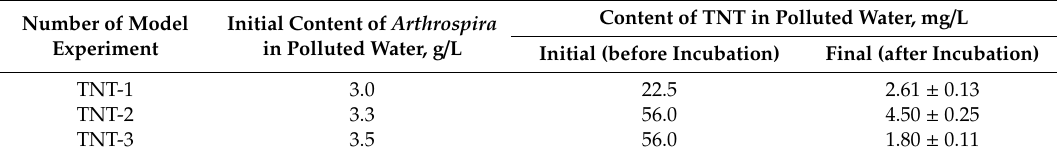
Table 2. Results of model experiments for cleaning water polluted with TNT by using Arthrospira . Mean values (n = 3) and ± SD are given.